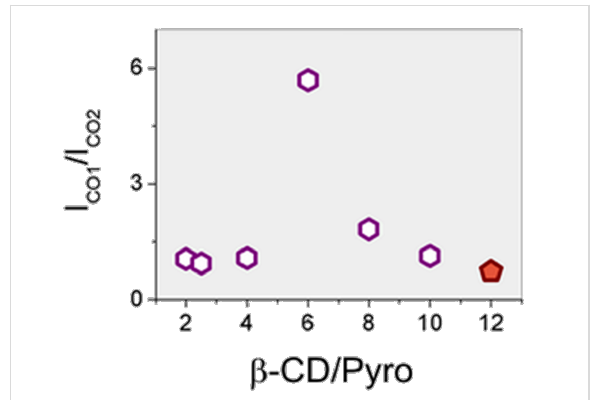
Figure 5: Ratio between the intensity of the bands assigned to ester groups (I CO1 ) and to the free carboxylic groups (I CO2 ) for cross-linked β -CD nanosponges (hexagons) and the β -CD-based polymer (pentagon). β -CD/Pyro = β -CD/pyromellitic dianhydride molar